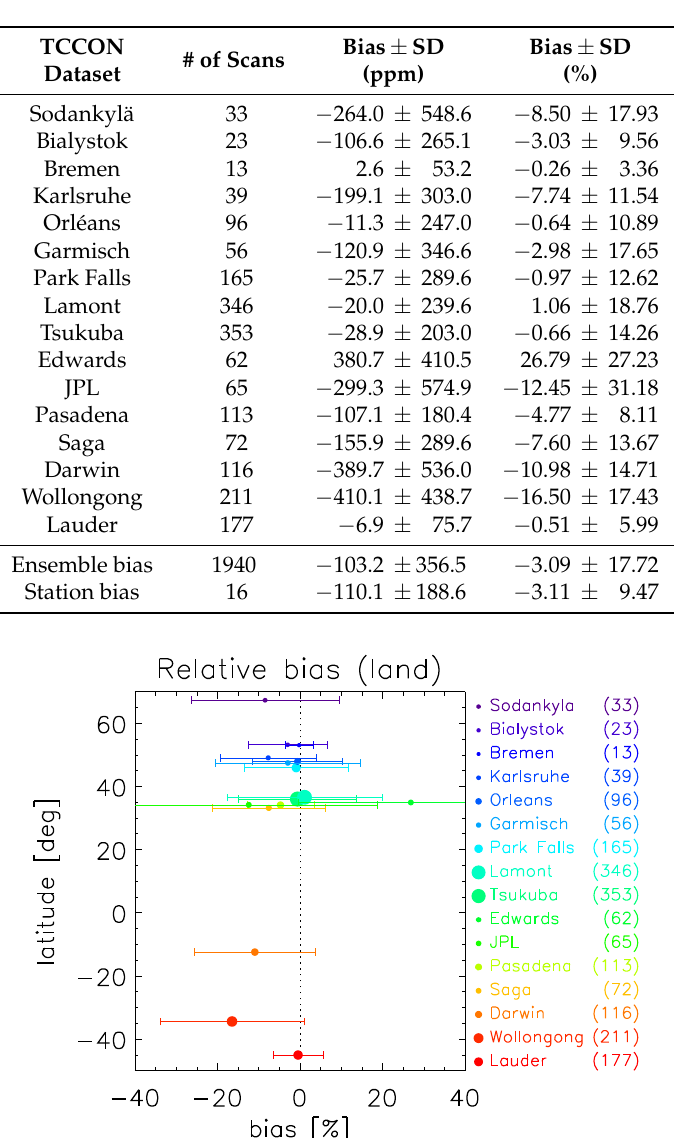
Table 2. Correction of Table 2 in [1]. Results of the comparison between TANSO-FTS scans acquired within ± 1 ◦ in latitude and in longitude of the TCCON sites and the average of TCCON measurements within ± 30min of the corresponding GOSAT overpasses. The number of matched scans is given. The absolute and relative values of the mean bias and standard deviation (SD) are indicated for each station. The ensemble and site-by-site results are also given.